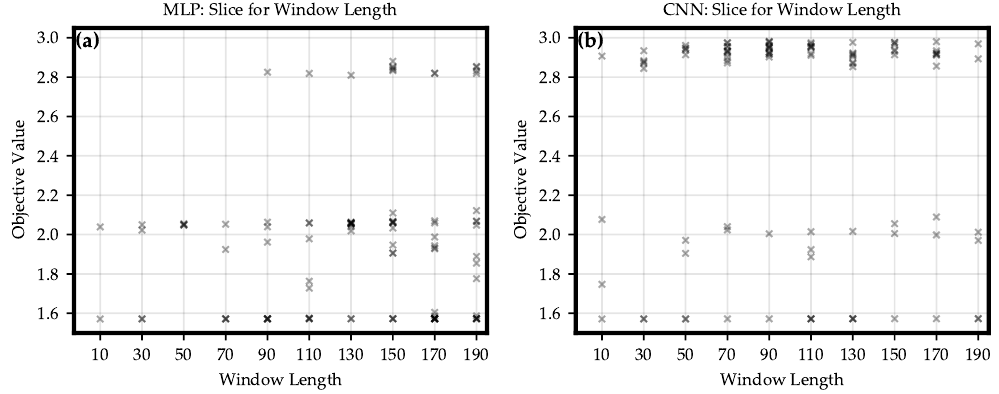
Figure 5. Comparison of hyper-parameter optimizations with focus on window length. Every cross represents a single trial. The crosses are drawn partially transparent, such that points which occurred more than once during optimization appear darker. In ( a ) the impact of the window length on the MLP-based optimization is shown, while in ( b ) the less influence of this parameter for the CNN-based optimization is presented.